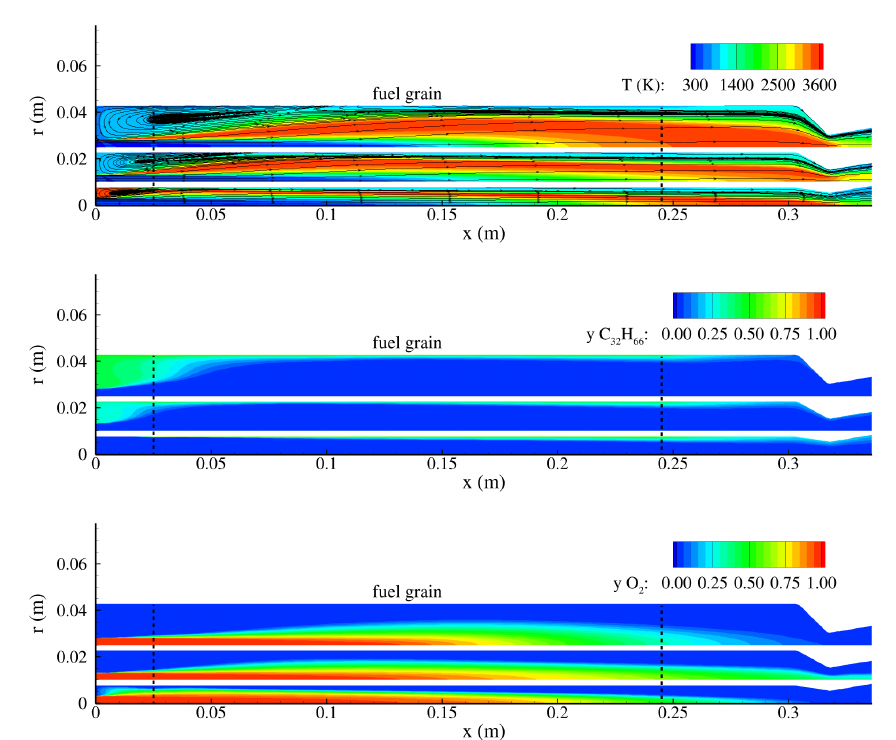
Figure 3. Temperature (with streamtraces), paraffin mass fraction, and oxygen mass fraction contours for test 4 of set 1 at different port